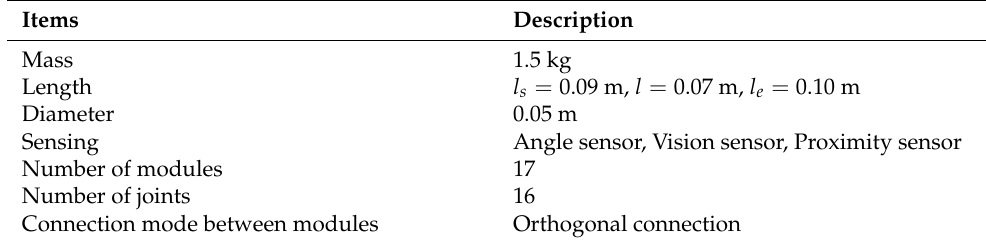
Table 2. Overview of snake robot specifications in